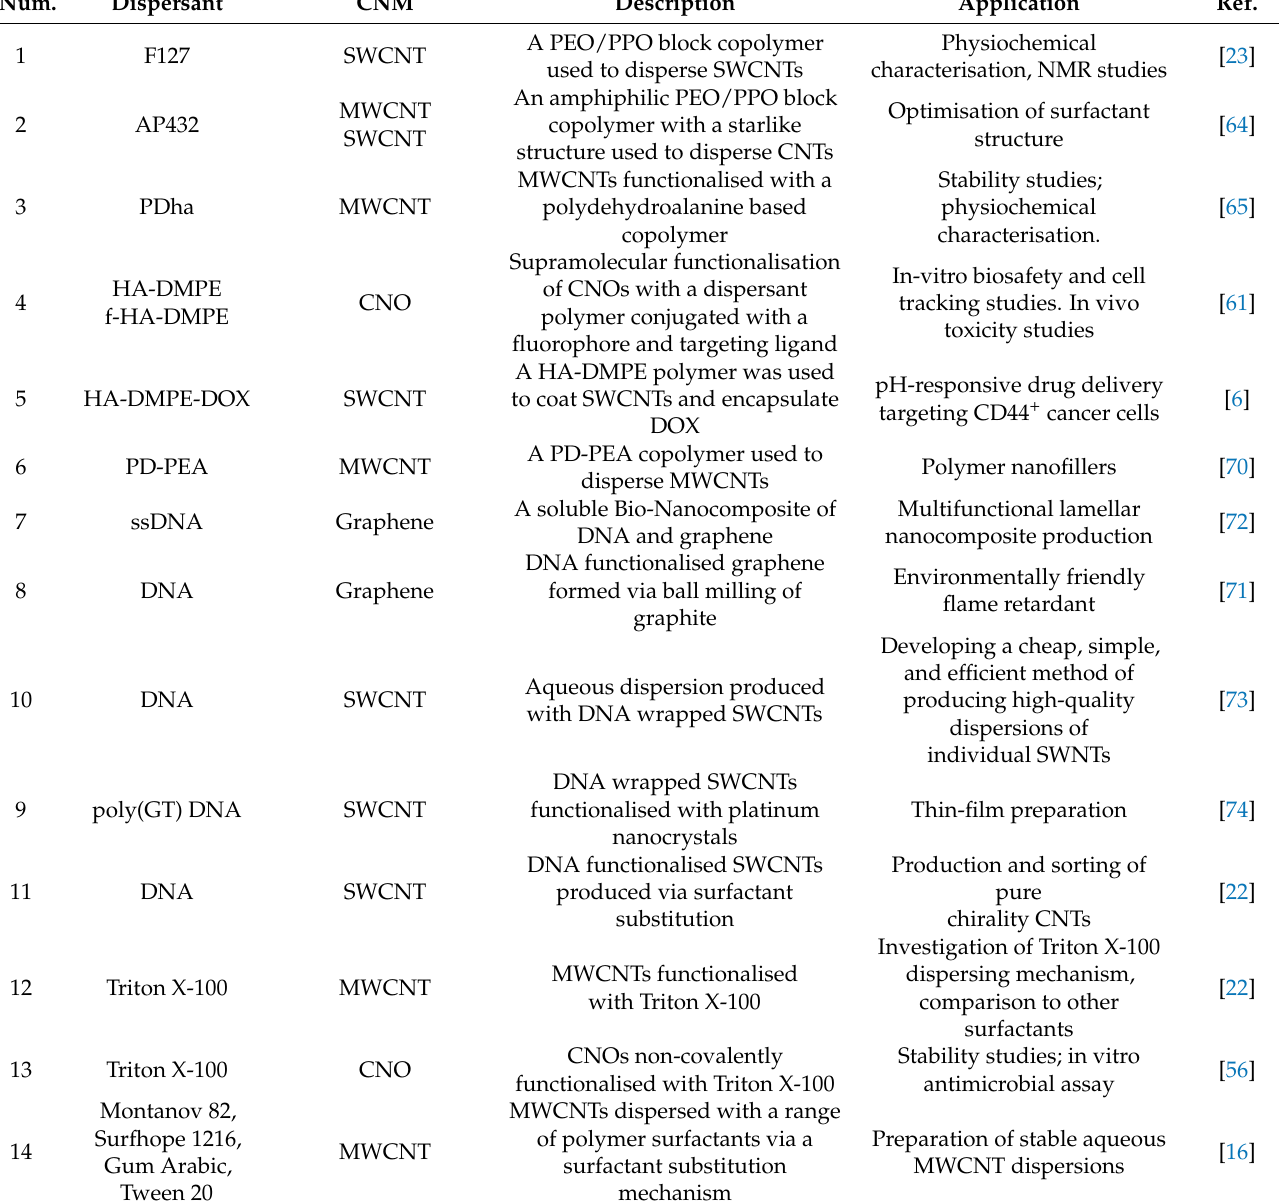
Table 5. Polymer dispersant based CNM